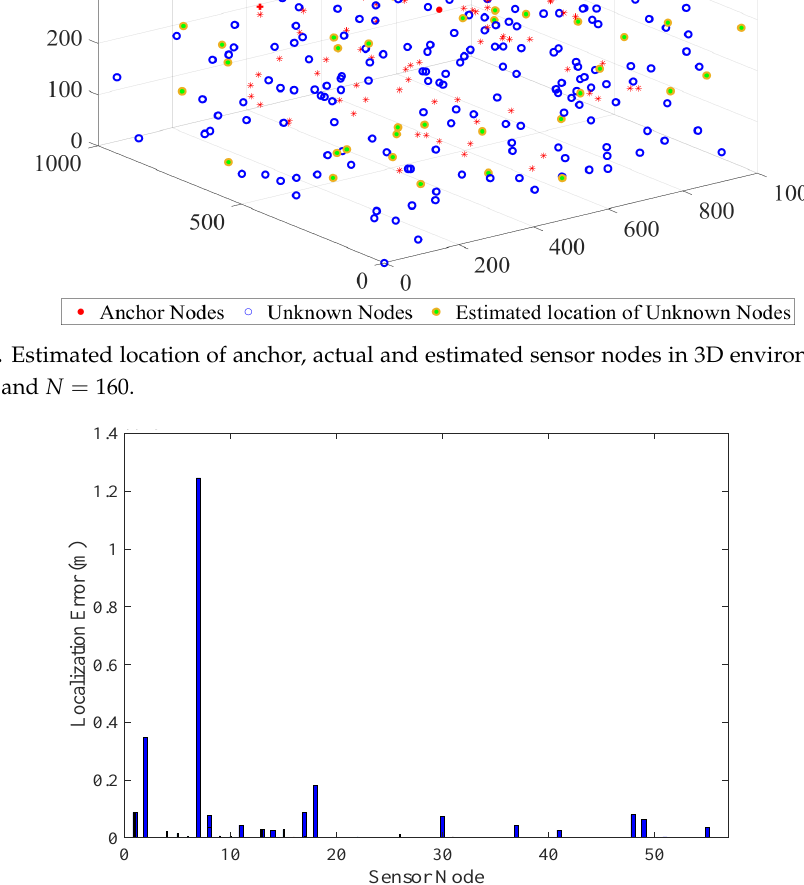
Figure 8. Relationship between localization error and no of sensor nodes.